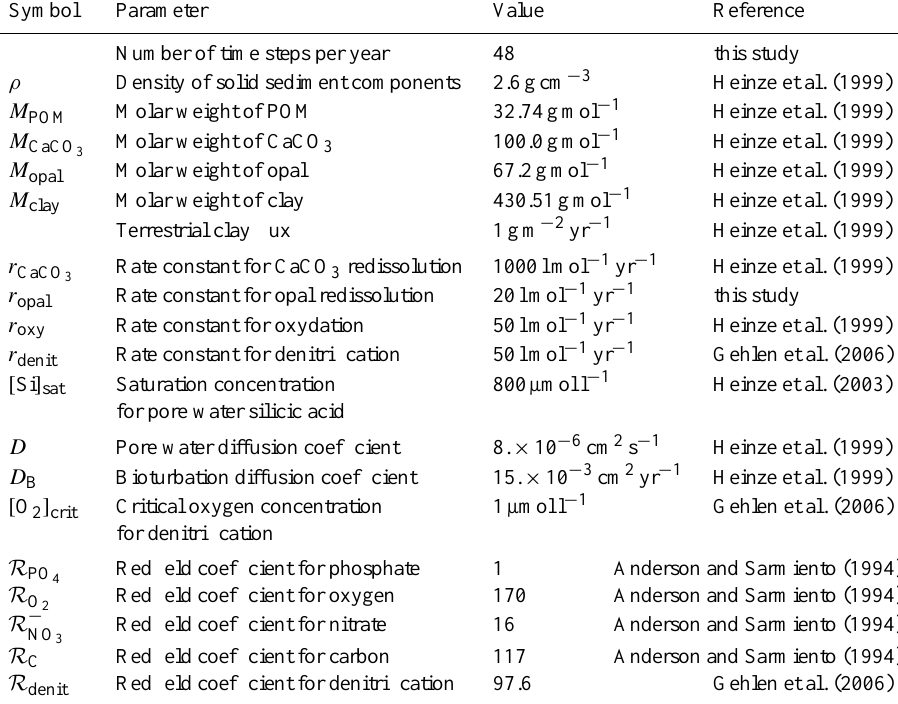
Table A1. Parameters for the sediment component of the Bern3D+C model along with standard values and references.